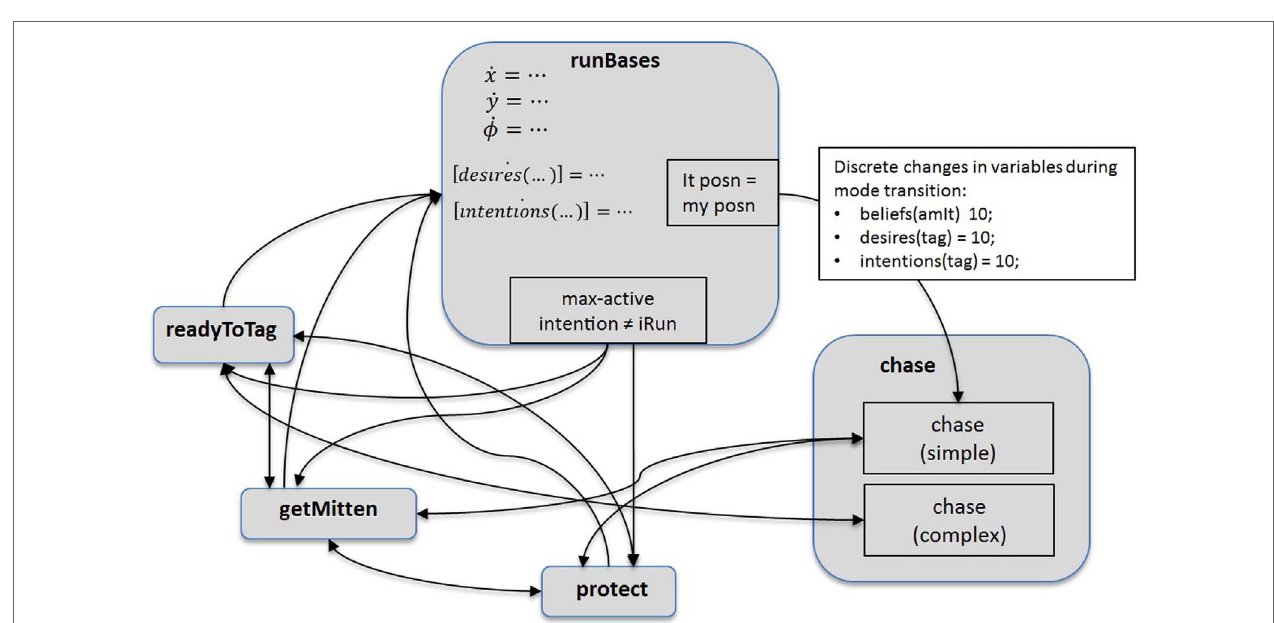
FIGURE 11 | Behavior mode-level architecture of a cognitive Tag agent (CTA) . Each mode also has a self-transition, omitted here to avoid visual clutter. [Aaron et al. (2011) contain additional details.]